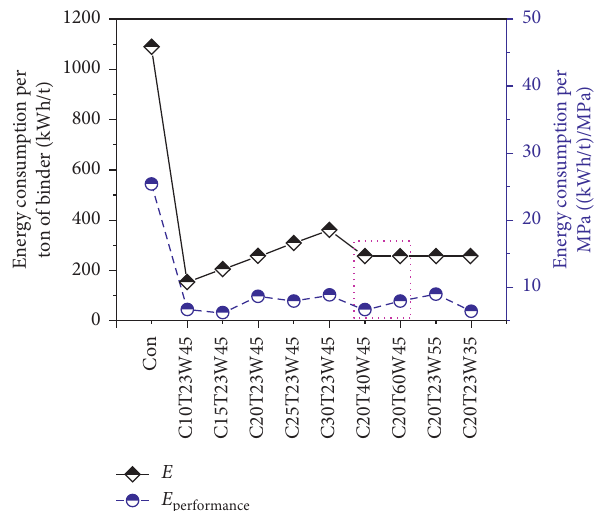
Figure 10: Ecoefficiency evaluation of mortars with and without